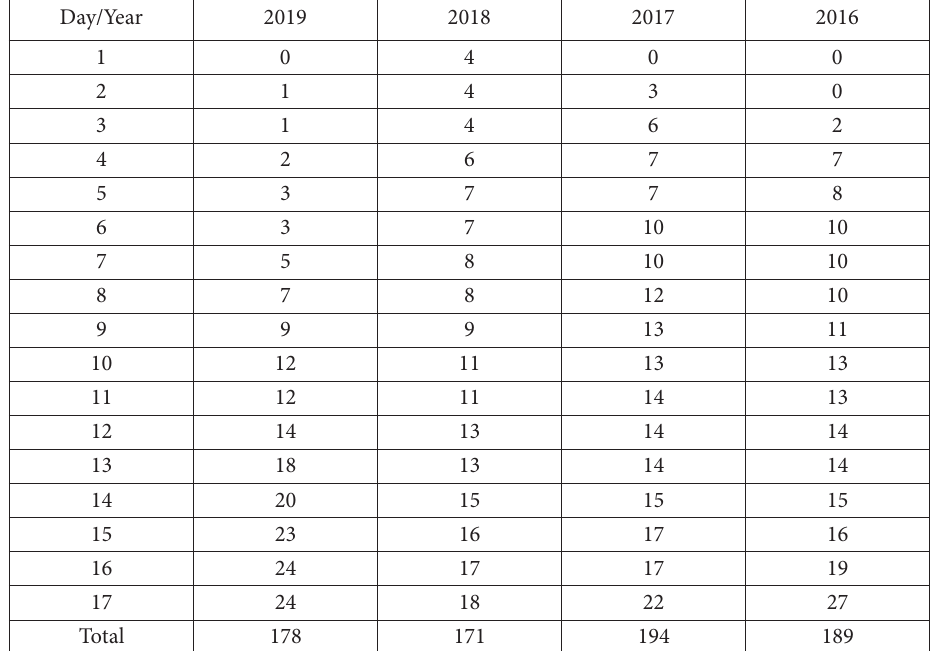
Table 1. Number of enrolled students between